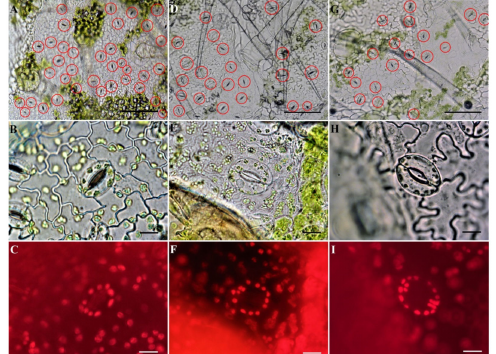
Figure 7. Epidermis of abaxial surface of leaves of courgette regenerant plants of different ploidy level obtained in unpollinated ovule culture in vitro: ( A – C ) plant with diploid set of chromosomes (2n = 2x = 40); ( D – F ) plant with triploid set of chromosomes (2n = 3x = 60); ( G – I ) plant with tetraploid set of chromosomes (2n = 4x = 80); ( A , D , G ) stomata cells in regenerant plants of different ploidy using 20 × lens; ( B , E , H ) stomata of regenerant plants of different ploidy levels using a 100 × lens; ( C , F , I ) autofluorescence of chloroplasts using a set of fluorescence filters using a 100 × lens. In the figures A,D,G stomata indicated by the circles.